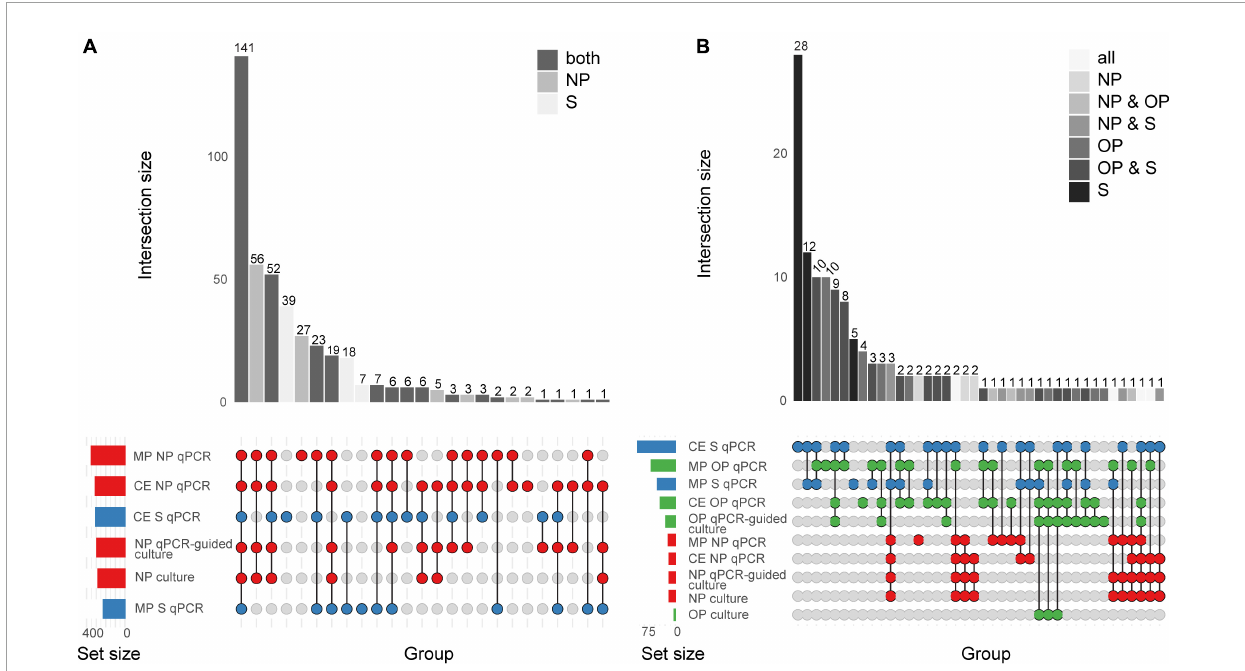
FIGURE2 Quantitative PCR-based detection of Streptococcus pneumoniae among saliva and nasopharyngeal (NP) samples from (A) young children ( n = 653) and (B) qPCR-based detection of S. pneumoniae among saliva (S), nasopharyngeal (NP), and oropharyngeal (OP) from adults ( n = 318). The intersection bar diagrams display the total number of individuals positive per intersection. The matrix diagram displays intersection components (method or criterion). The set size bar diagram displays the total number of individuals positive per intersection component. Saliva, oropharyngeal, and nasopharyngeal samples are colored blue, green, and red, respectively, in the matrix diagram. “MP” stands for minimally processed, “CE” stands for culture-enrichment. “qPCR” stands for samples identified as positive for pneumococcus according with molecular method of qPCR and applying study criteria for positivity. “Culture” stands for isolation of viable S. pneumoniae from either primary diagnostic, or qPCR-guided culture.